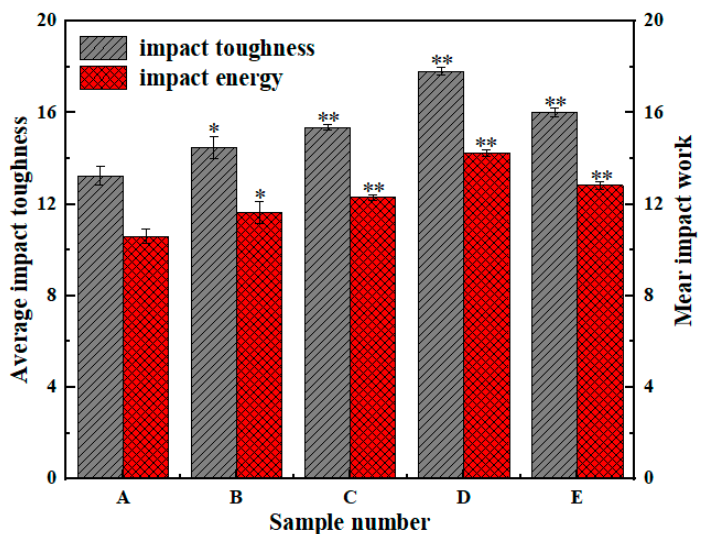
Figure 11. Charpy impact tests: ( A ) 65 Mn; ( B ) 1200 W; ( C ) 1400 W; ( D ) 1600 W; ( E ) 1800 W.